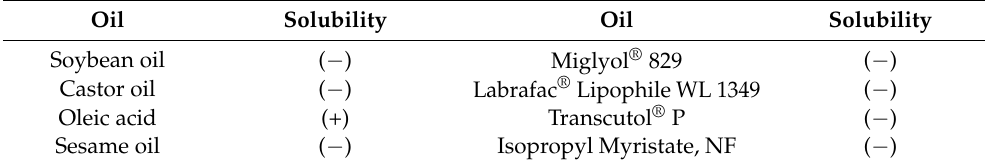
Table 1. Oil screening studies for moxifloxacin.